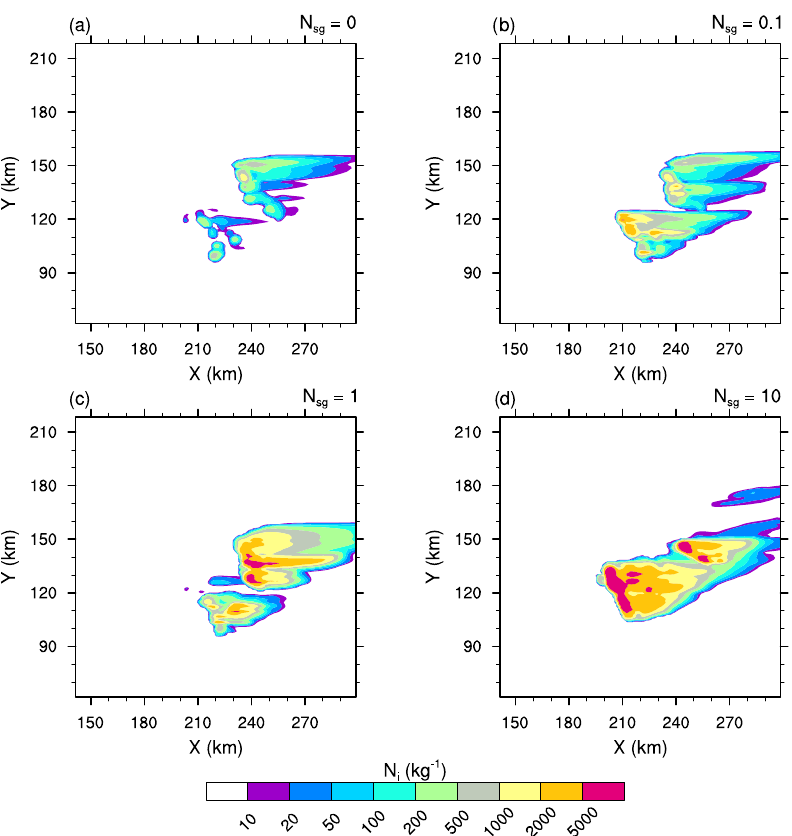
Figure 6. Number concentration of the cloud ice ( N i in log scale) of the STERAO simulations at 15km height, where panels (a) – (d) refer to cases with N sg = 0 . 0, 0.1, 1.0, and 10.0 ice fragments per collision, respectively. The plots are for a fraction of the computational